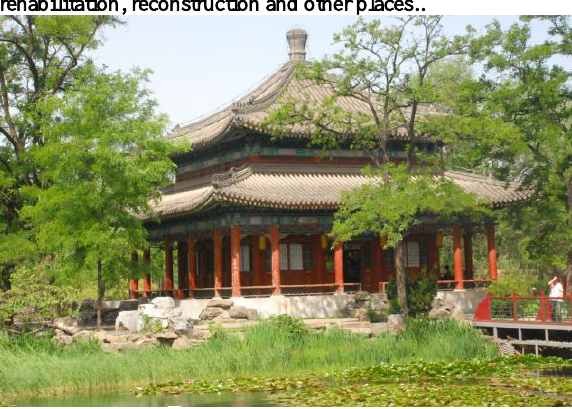
Figure 4. rehabilitation of “Jian bi” Pavilion